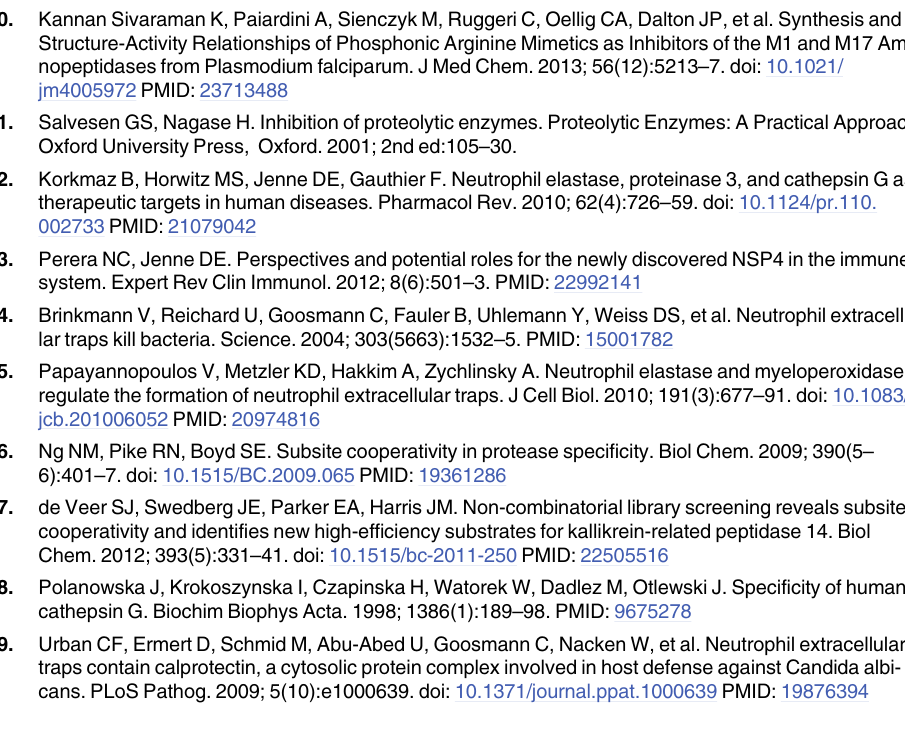
PLOS ONE | DOI:10.1371/journal.pone.0132818 July 14,